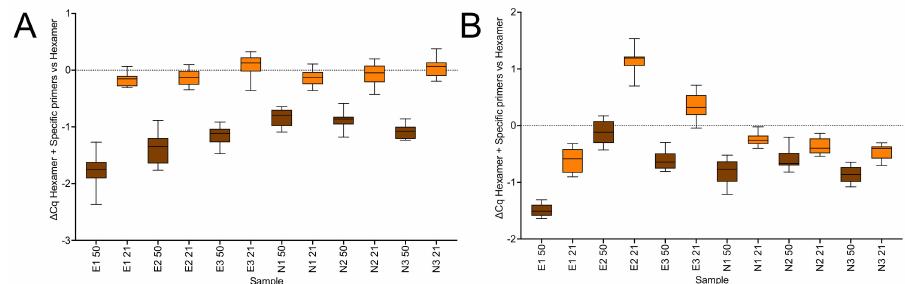
Figure 5. Amplification of RNA reverse transcribed with random hexamers only or with additional specific reverse primers targeting the E (E1–3) and N (N1–3) genes, respectively, and detected using hydrolysis probes. ( A ) SS4: ∆ Cqs for RT reactions carried out with and without specific reverse primers at 50 ◦ C (brown) and at 21 ◦ C (orange). ( B ) US2: ∆ Cq for the reactions carried out with and without specific reverse primers at 50 ◦ C (brown) and at 21 ◦ C (orange). All box and whiskers plots show the ∆ Cqs for the independent RT-qPCR reaction, with the whiskers delineating the minimum and maximum values.